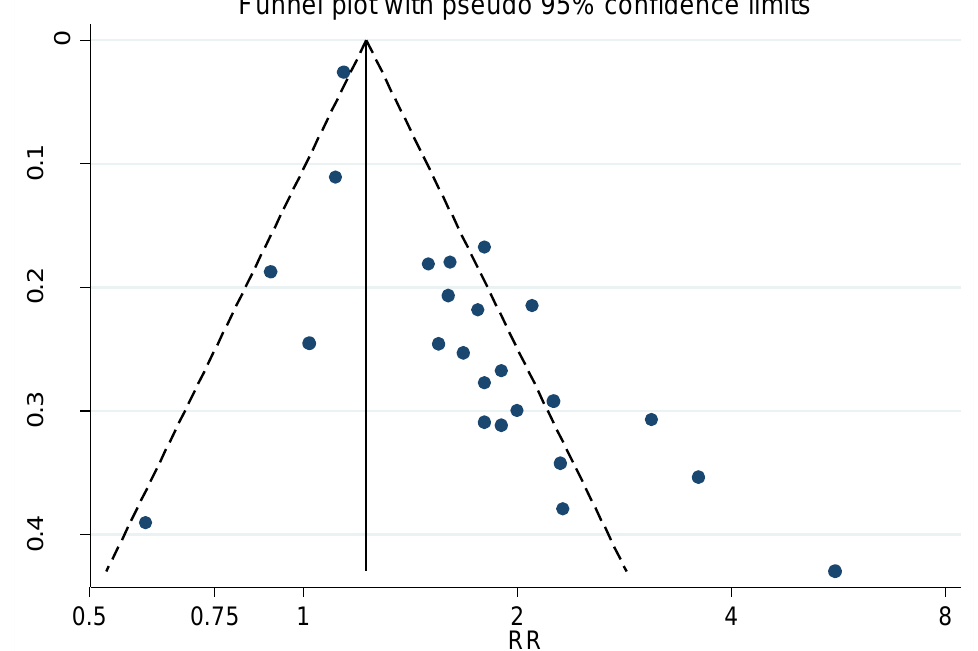
Figure 6. Funnel plot for the relative risk (RR) estimates from studies of the association between Parkinson’s disease and occupational exposure to Pesticides, Begg’s test = 0.026.